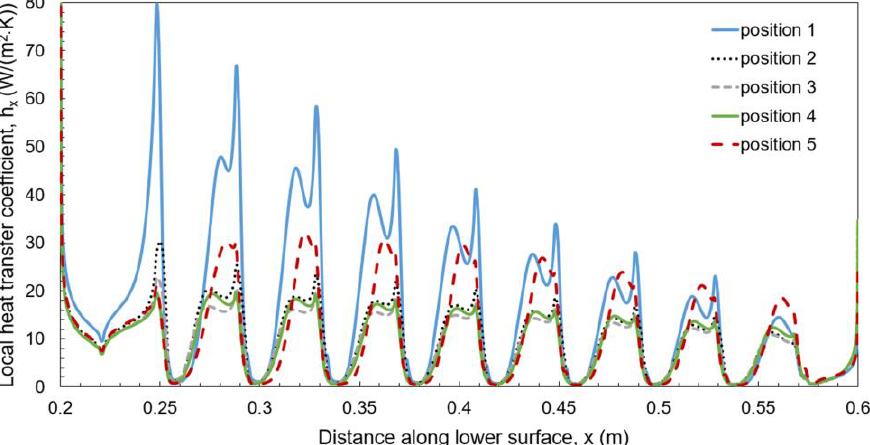
Figure 12. The comparison of local heat transfer coefficients along lower surfaces of the WCCA15 for CVGs position ‘1’ to ‘5’ and Re = 857.